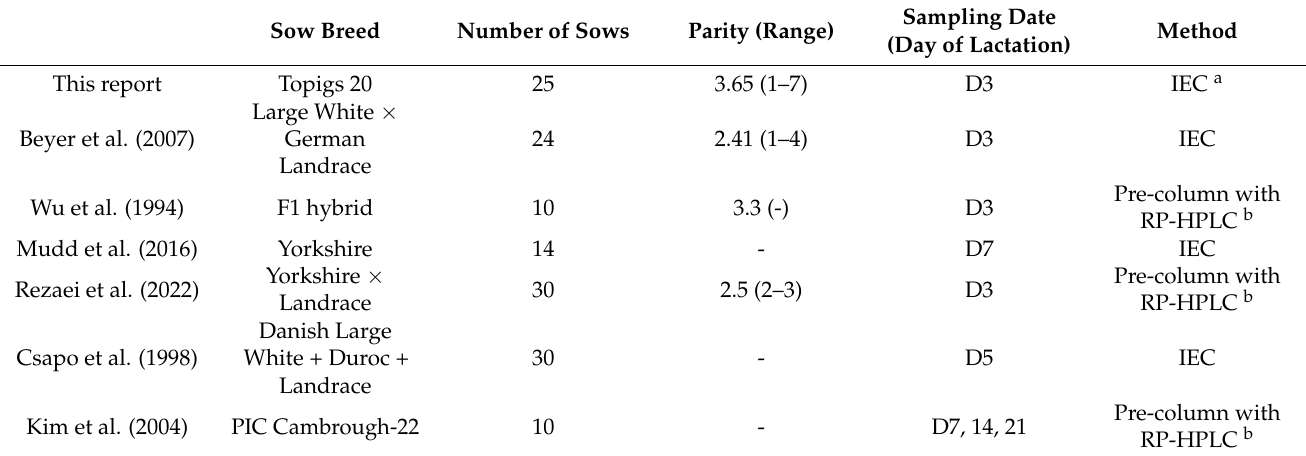
Table 1. An overview of potential factors influencing sow milk composition in different